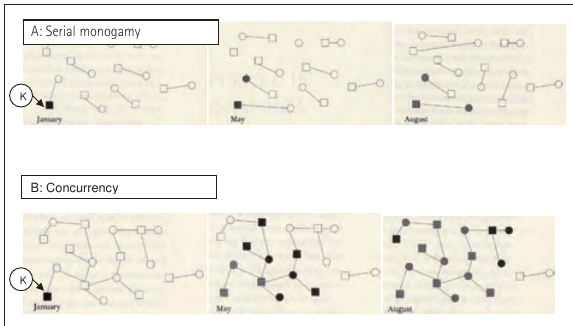
Fig. 1. The effect of sexual network configuration on HIV transmission in two hypothetical populations with the same number of lifetime partners, but differing concurrency patterns. Population A has a pattern of serial monogamy, while most of population B are connected in a concurrent network. In both populations individual K (bottom left) contracts HIV in January. In A, the individual will have a high probability of transmitting the infection on to his January partner while in seroconversion and then a lower probability of passing it onto his next partners. The future partners of K’s infected January partner are also less likely to be infected owing to the reduced chances of their having sex during seroconversion. In B, the virus spreads rapidly through the network, as each person who becomes infected has a much higher probability of transmitting the virus onto another partner due to the fact that they are much more likely to have sex with the other partner/s during the seroconversion period (diagram based on one by Epstein H. 2008. The Invisible Cure: Africa, the West and the Fight against AIDS. Picador, 2008, reproduced with permission). CAPS dataset found that 38% of black females (versus 14% of other racial/ethnic groups) report that at least one current or previous partner definitely had another sexual relationship during their relationship. The corre- sponding figures for males are 28% for blacks and 10% for the others. Turning to whether or not the respondent ever had two simultaneous sexual relationships, this was the case for 41% of black males, and 4% and 21% for white and coloured males, respectively (Kenyon C et al . – unpublished data).